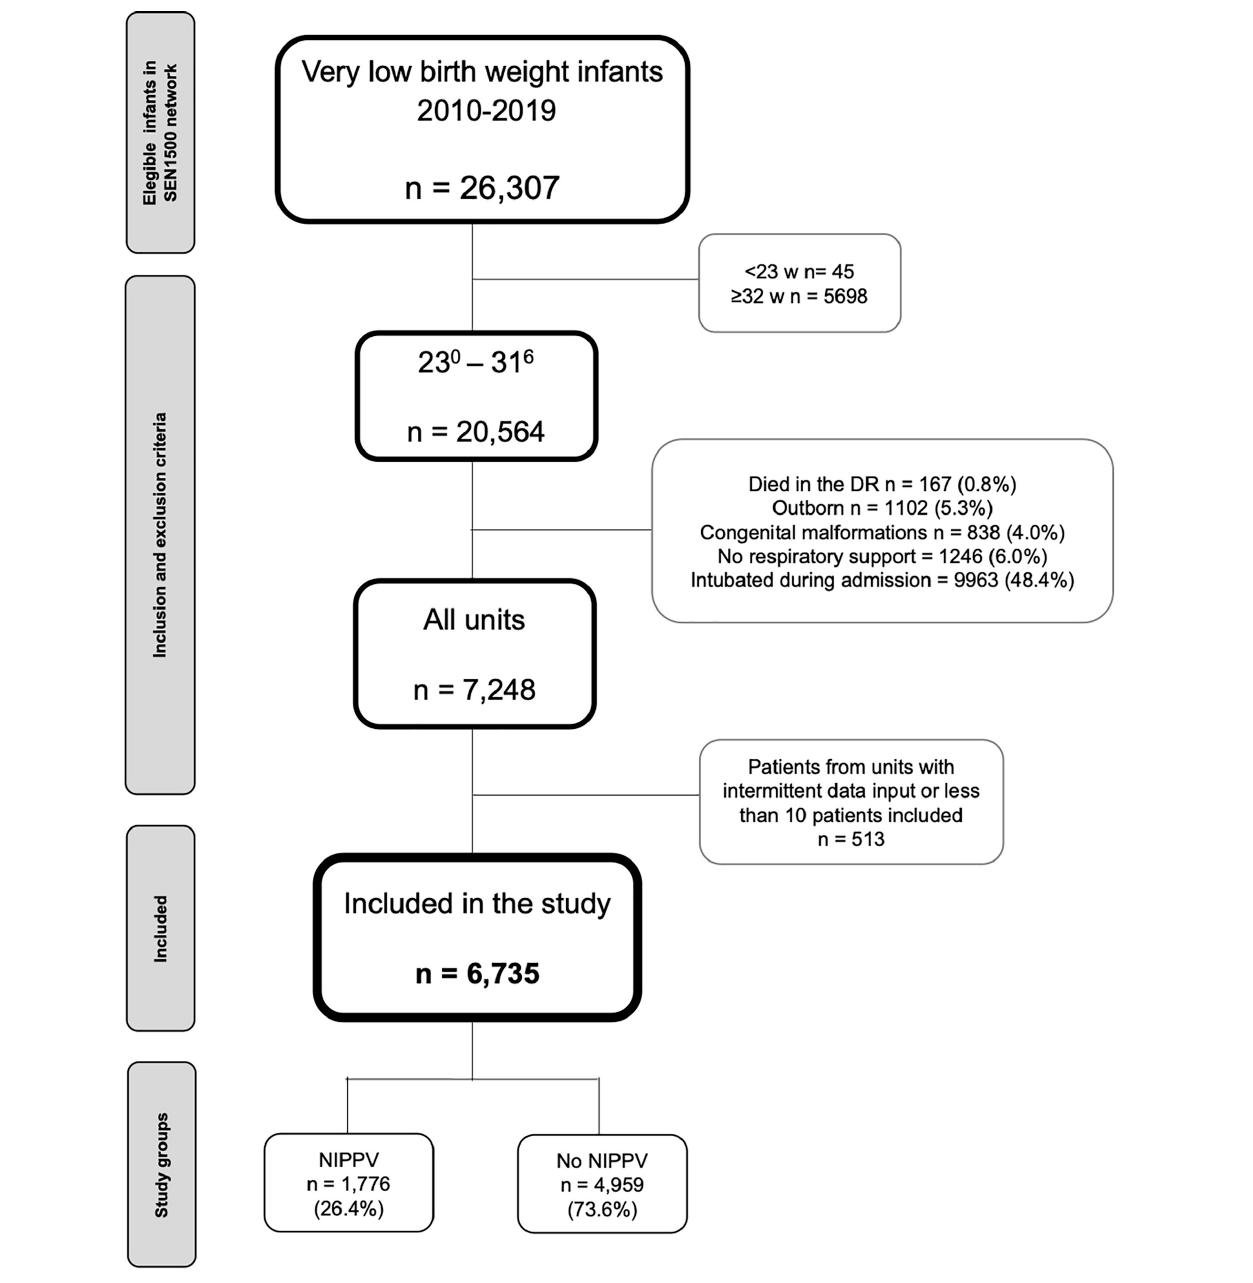
FIGURE 1 | Flow chart depicting the recruitment of the cohort. DR, delivery room; NIPPV, non-invasive positive pressure ventilation.